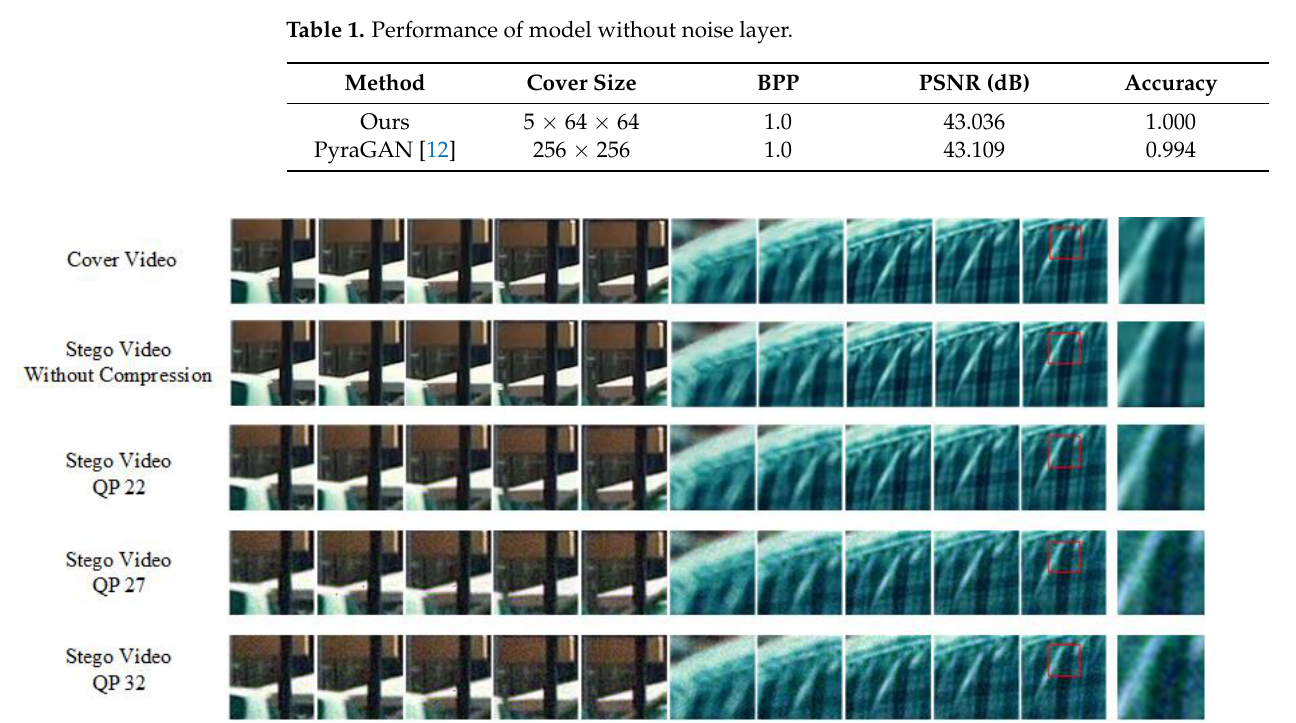
Figure 7. Cover video and stego videos.